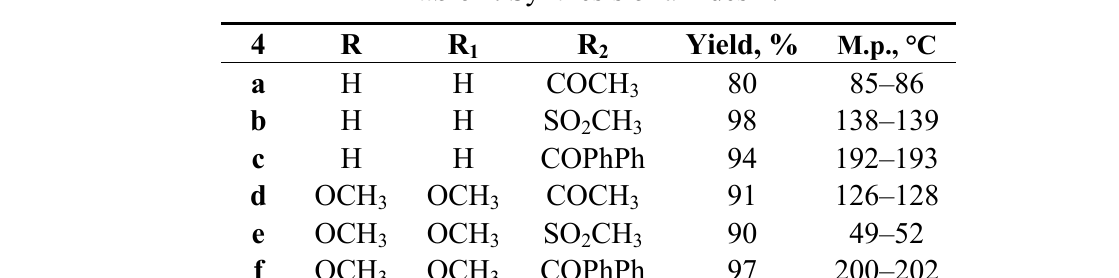
Table 2. Synthesis of amides 4